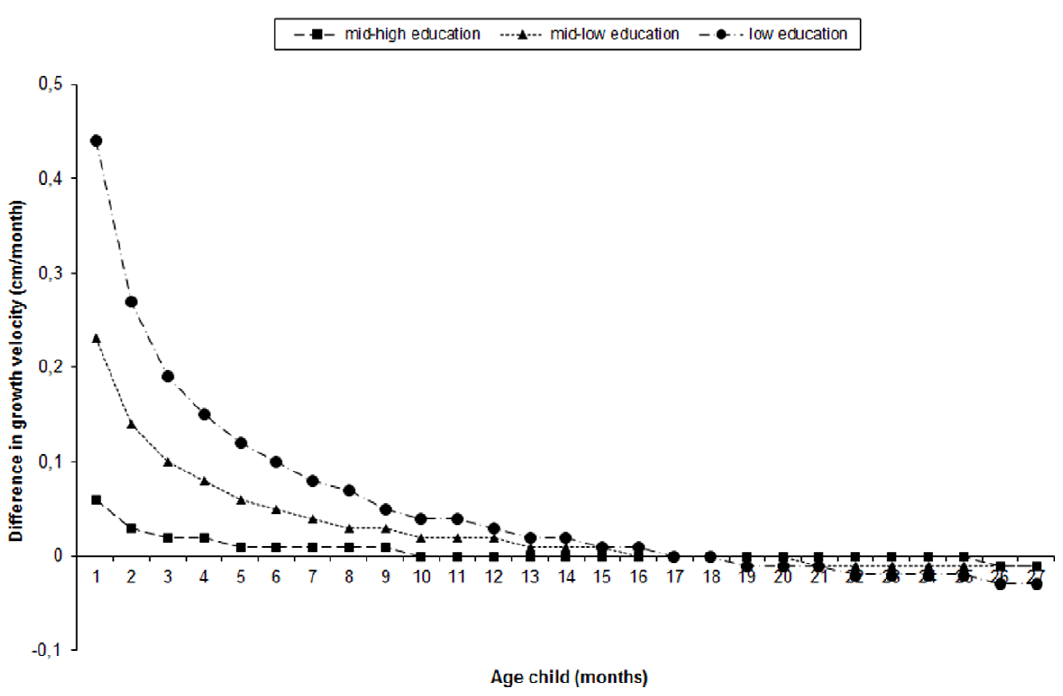
Figure 3. Difference in linear growth velocity, with children of mothers with high education as reference group (n=2972). Growth curves are derived from linear mixed models. Difference in growth velocity=ß 1 *educational level + ß 2 *0.5*1/ ! age*educational level.